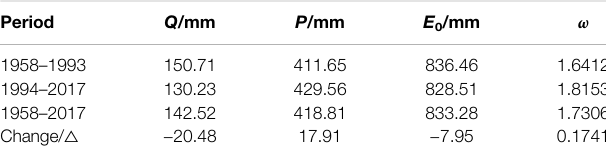
TABLE 2 | The changes of stream fl ow and meteorological and watershed characteristic parameter in two periods. Period